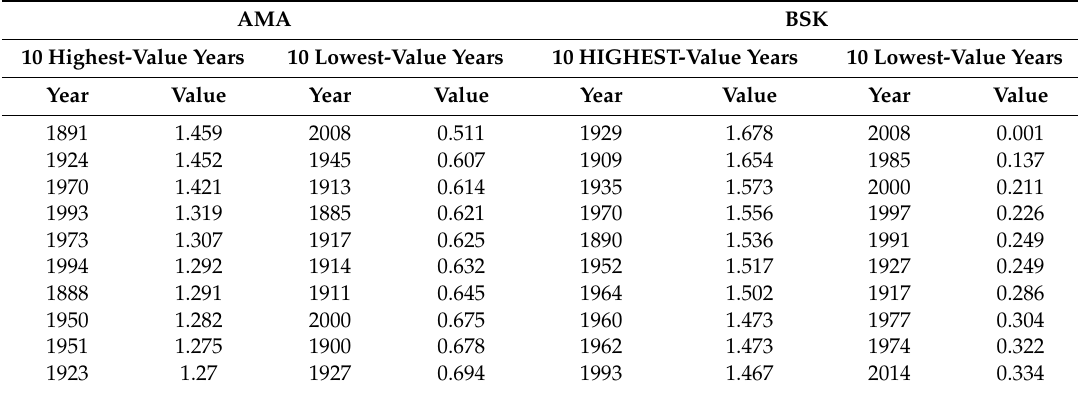
Table 3. Highest- and lowest-value years of tree-ring chronologies for the common period 1880–2016.